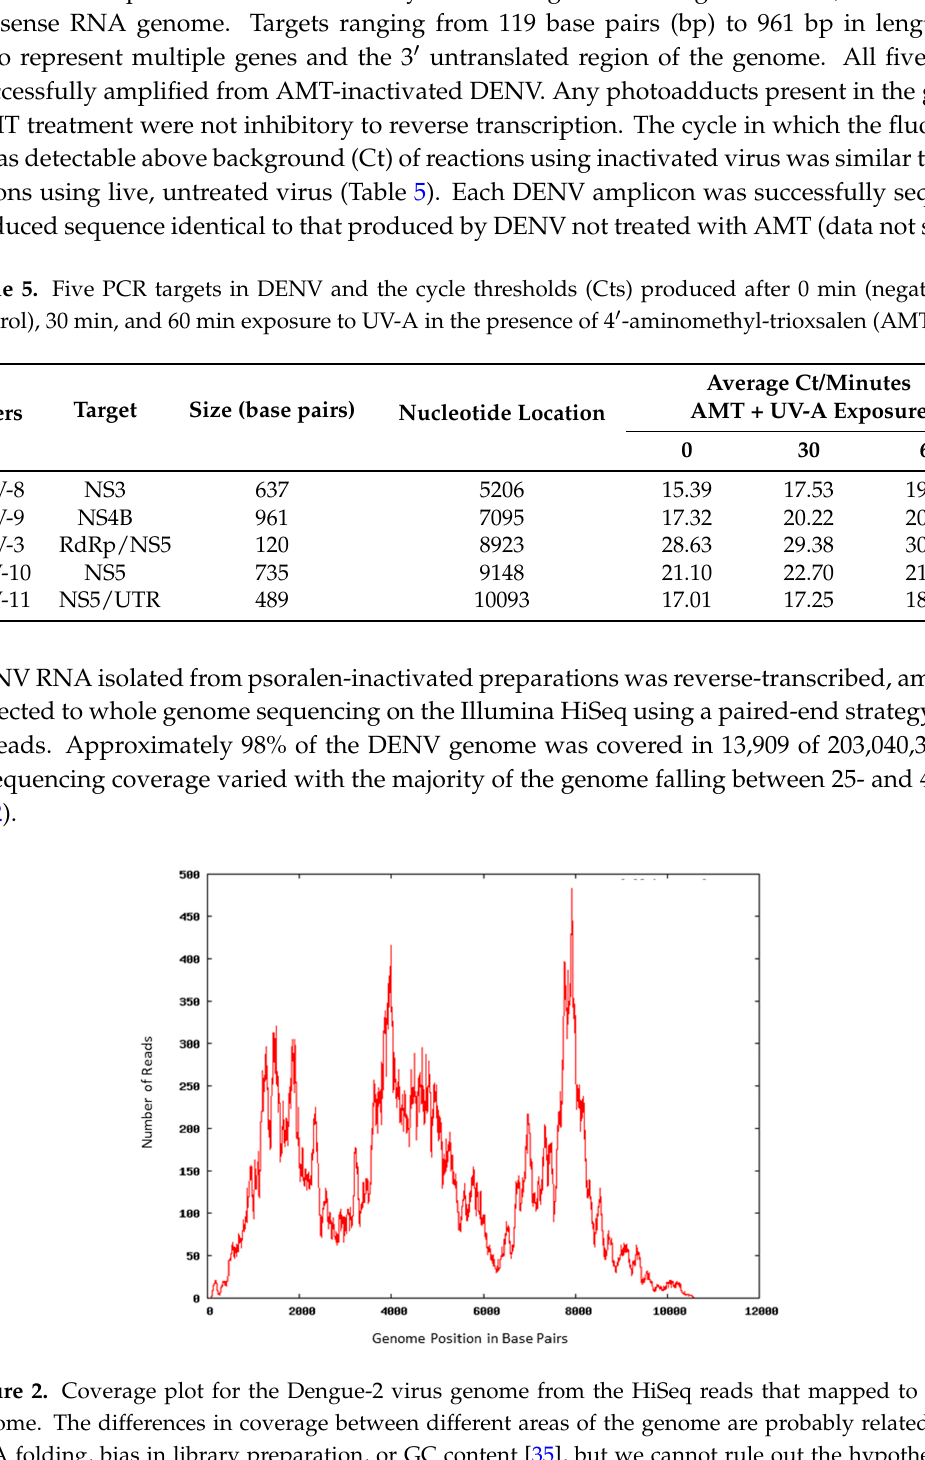
Table 5. Five PCR targets in DENV and the cycle thresholds (Cts) produced after 0 min (negative